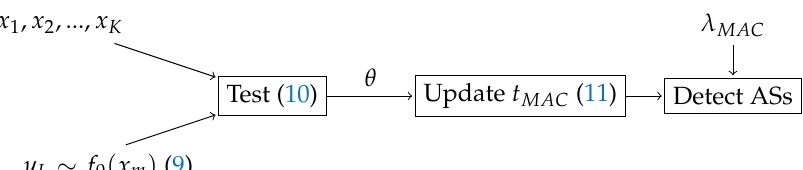
Figure 3. Block diagram for the defense mechanism against the backoff attack. The inputs are a set of K backoff windows used by a sensor and a set of L backoff window sampled from f 0 ( x m ) (9). In this case, the defense mechanism parameters are K , L and λ MAC , and the result is an updated list of sensors detected as